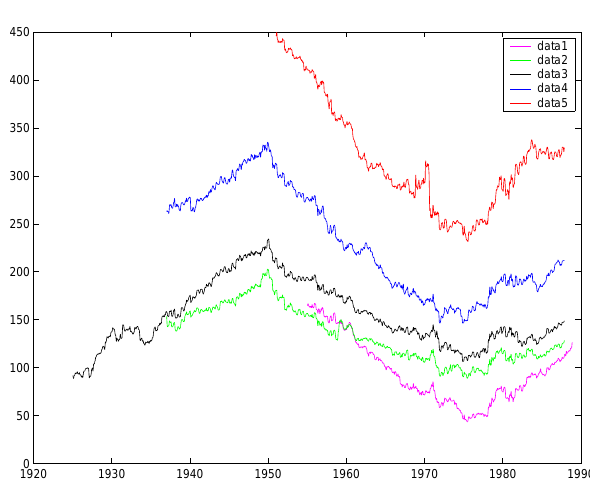
Fig. 5. Map of the observatories included in the study.